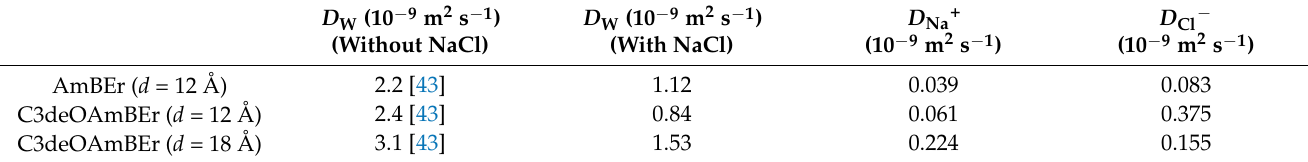
Table 3. Calculated diffusivity of water molecules and hydrated ions inside the